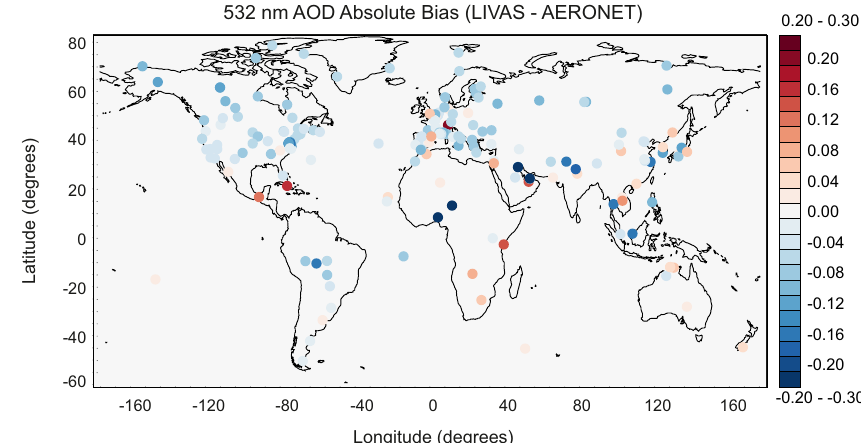
Figure 15. Spatial distribution of the 532nm AOD absolute biases (LIVAS averaged AOD minus AERONET averaged AOD).